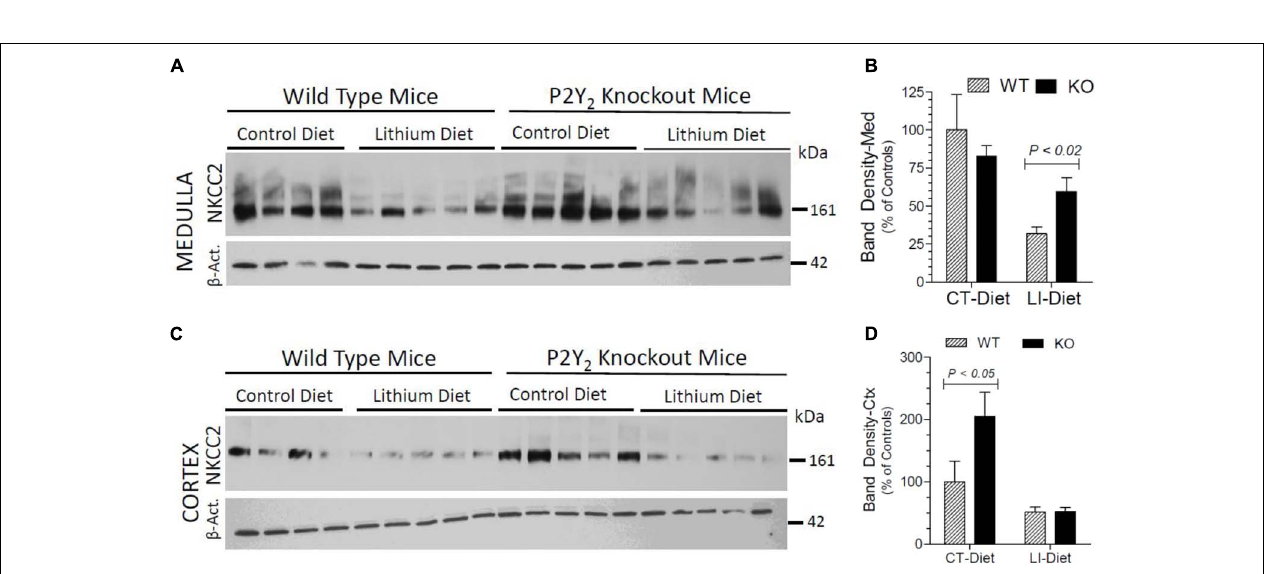
FIGURE 7 | Terminal (5 months) protein abundances of NKCC2 in the kidney of mice fed control or lithium-added diet determined by Western blotting. (A) Immunoblot profile of NKKC2 and β -actin protein bands in the renal medulla of different groups of mice. (B) Mean densitometric values of normalized NKCC2 and β -actin protein bands in the medulla expressed as percent of mean values in the control diet fed WT mice. (C) Immunoblot profile of NKKC2 and β -actin protein bands in the renal cortex of different groups of mice. (D) Mean densitometric values of normalized NKCC2 and β -actin protein bands in the cortex expressed as percent of mean values in the control diet fed WT mice. Statistical significance between the groups by one-way ANOVA is shown over the bars. For the results of two-way ANOVA refer to Table 1 .